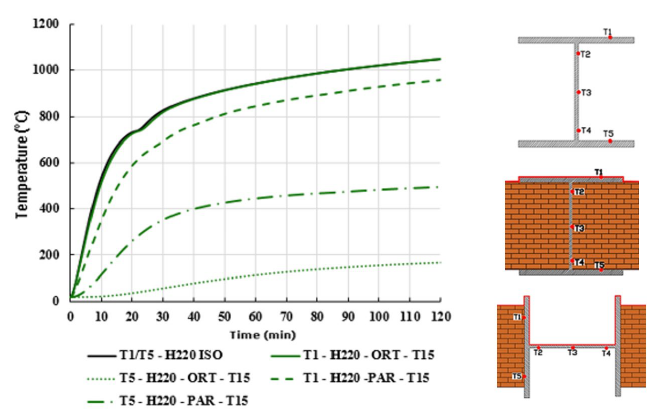
Figure 9. Curve referring to temperature as a function of time for isolated steel columns and steel columns inserted into the wall, in contact with the flanges or with the web.